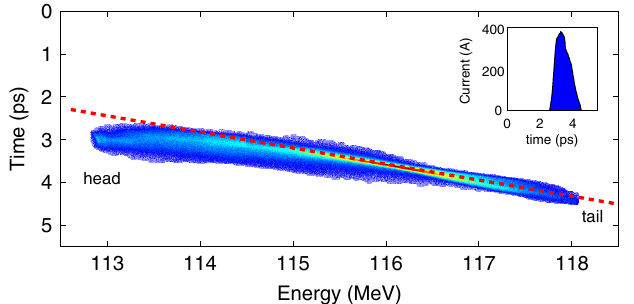
FIG. 8. Measured longitudinal phase space and current profile for a compressed beam with C ¼ 7 . The red line has been drawn as a reference to show the chirp deviation from linearity toward the bunch head, as predicted in Fig. 7. The top left corner shows the beam current